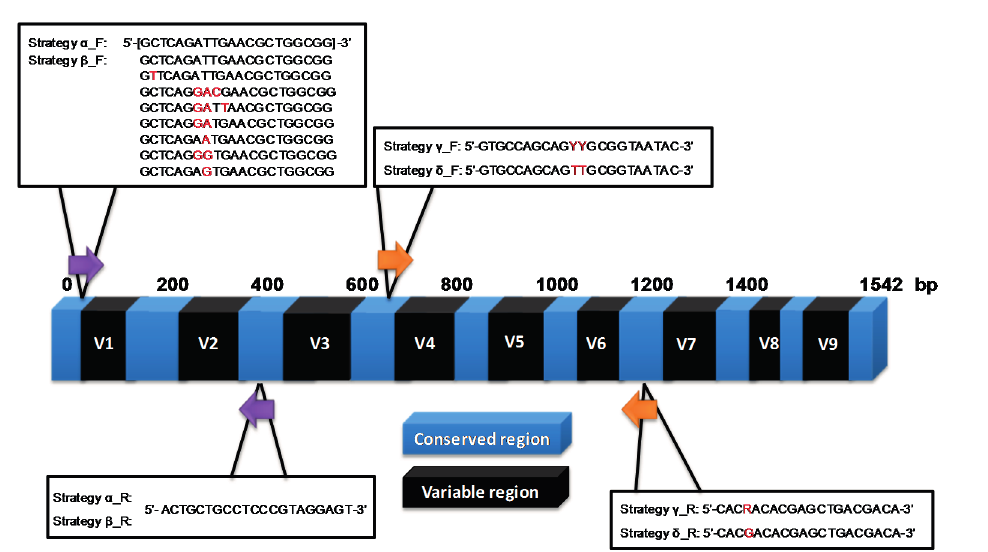
Figure 2. A summary of the four different primer strategies for amplification of variable regions 1, 2, 4, 5 and 6 of the 16S rRNA gene (positioning is based on the E. coli 16S rRNA gene). Highlighted in red are differences in base